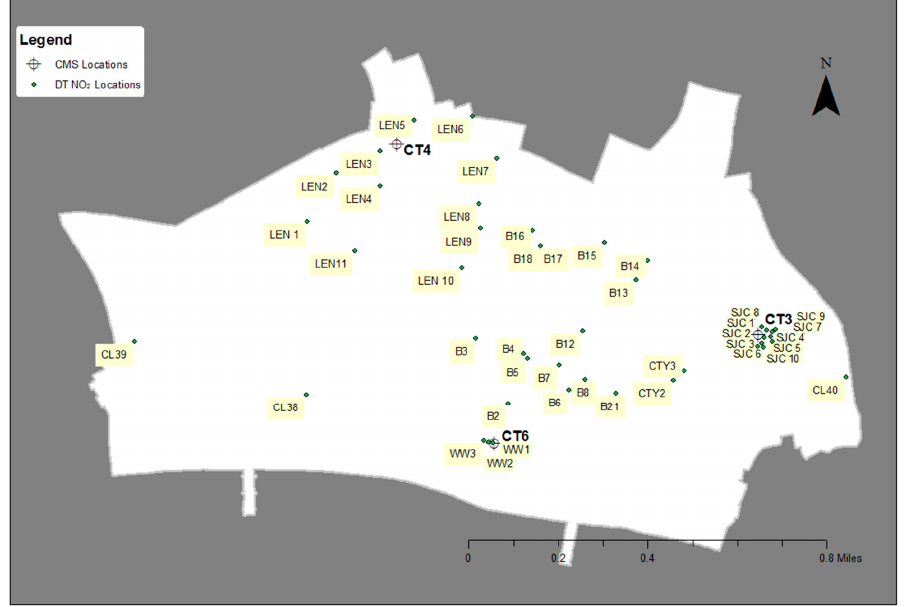
Figure 2. City of London CMS and Diffusion Tube locations.